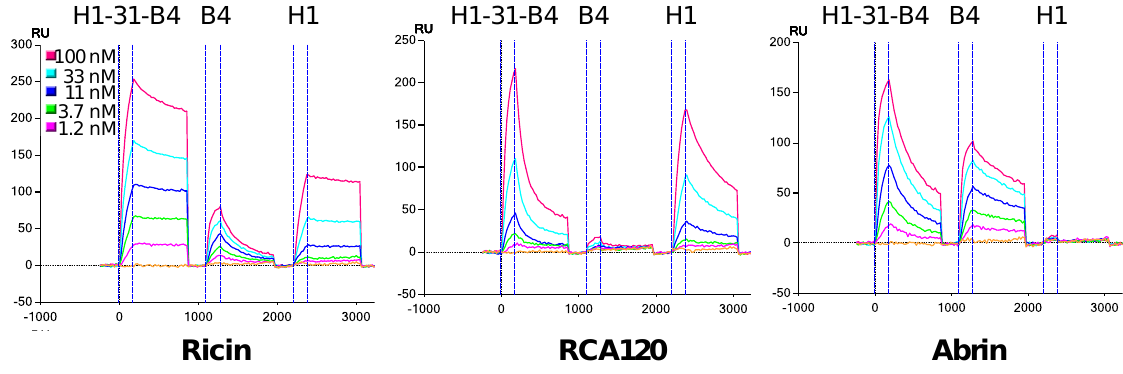
Figure 1. Binding of H1-31-B4, and parental sdAb-B4 and sdAb-H1 to ricin ( left ), RCA120 ( middle ) and abrin ( right ). The H1-31-B4 binds to all three targets, showing that each of the component sdAb is able to recognize target. The X axis is time in seconds, while the Y is the SPR signal reported in resonance units (RU). The different colored curves represent dilutions of the sdAb and linked construct as indicated in the figure. The vertical lines represent the beginning and ending of the injection of linked or parental